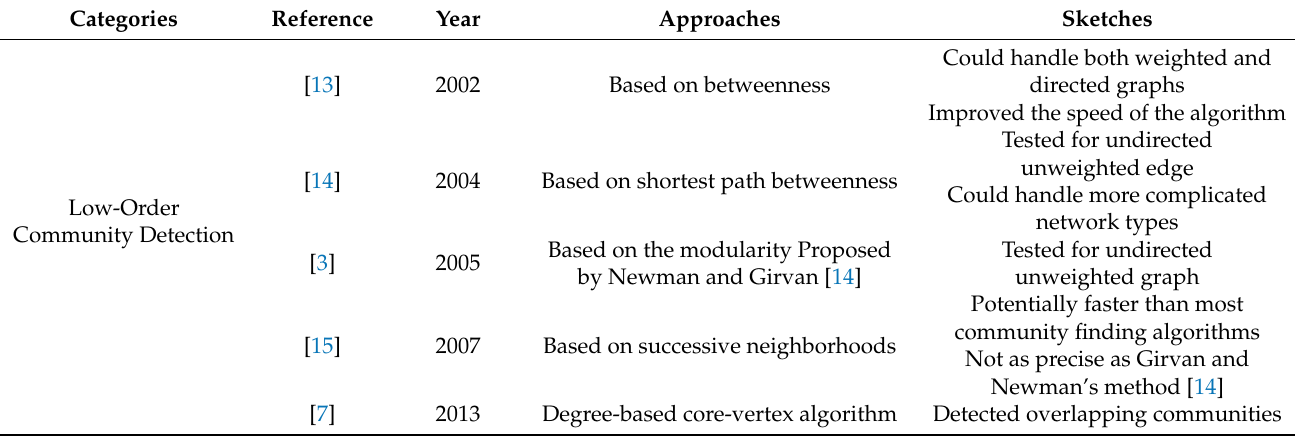
Table 1. A brief comparison of community detection